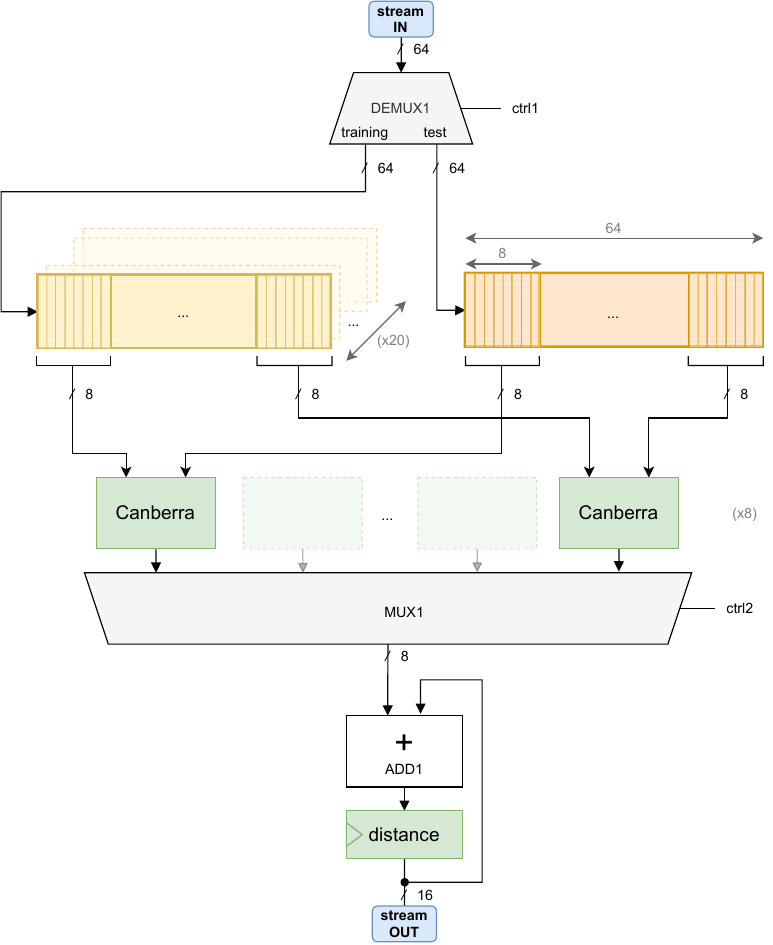
Figure 6. Block diagram of calculate distances